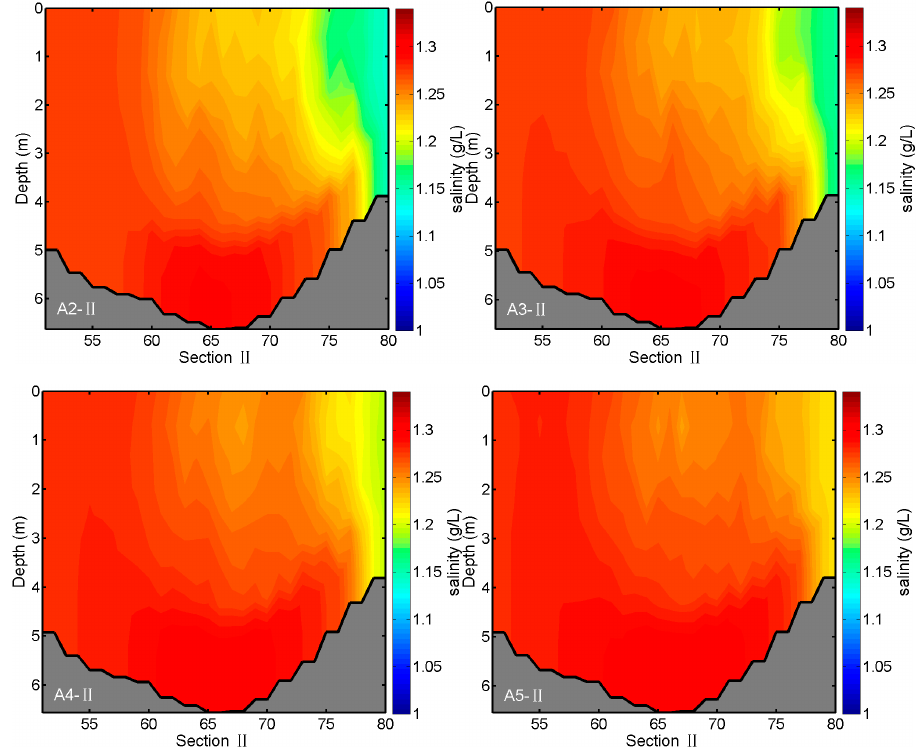
Figure 13. Distribution of modeled salinity at Section II in experiment ( A2- II ) A2, ( A3- II ) A3, ( A4- II ) A4, and ( A5- II ) A5.